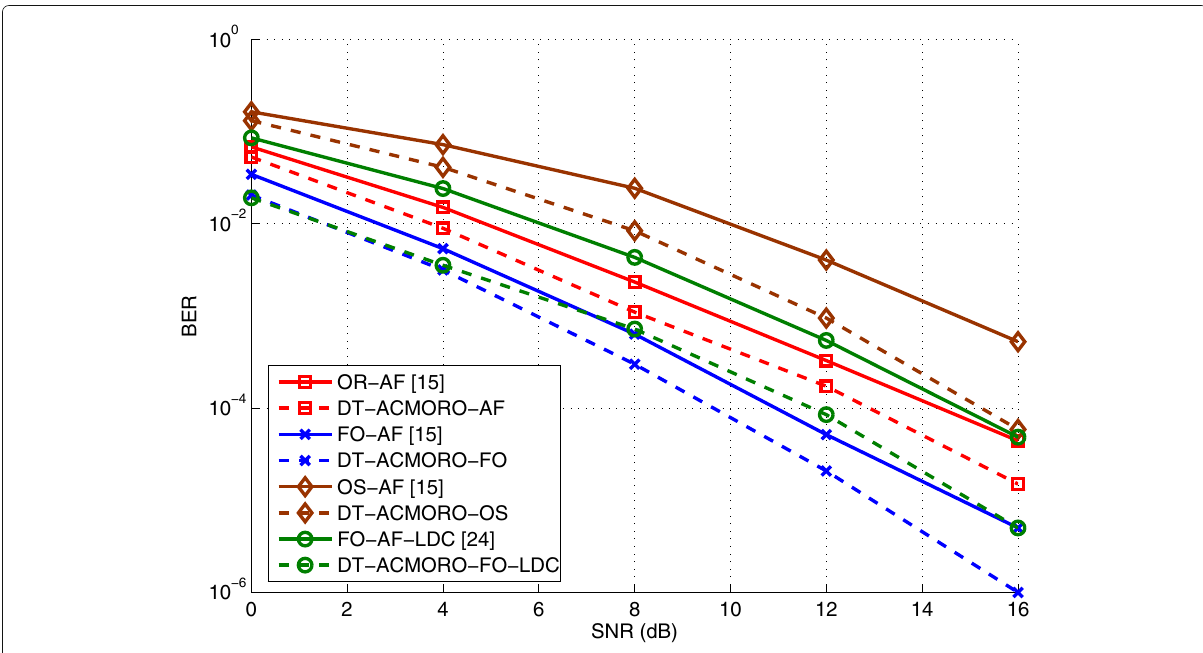
Fig. 6 BER performance vs. SNR for DT-ACMORO SG algorithm for SAS